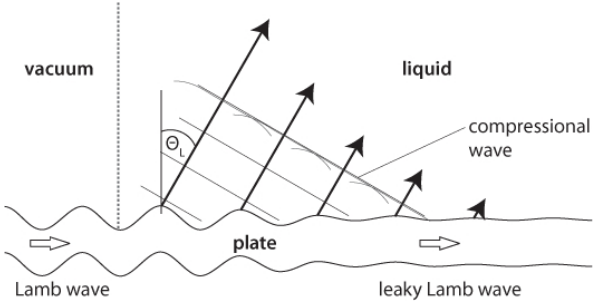
Figure 7. Excitation of a pressure wave into the adjacent liquid by mode conversion of a Lamb